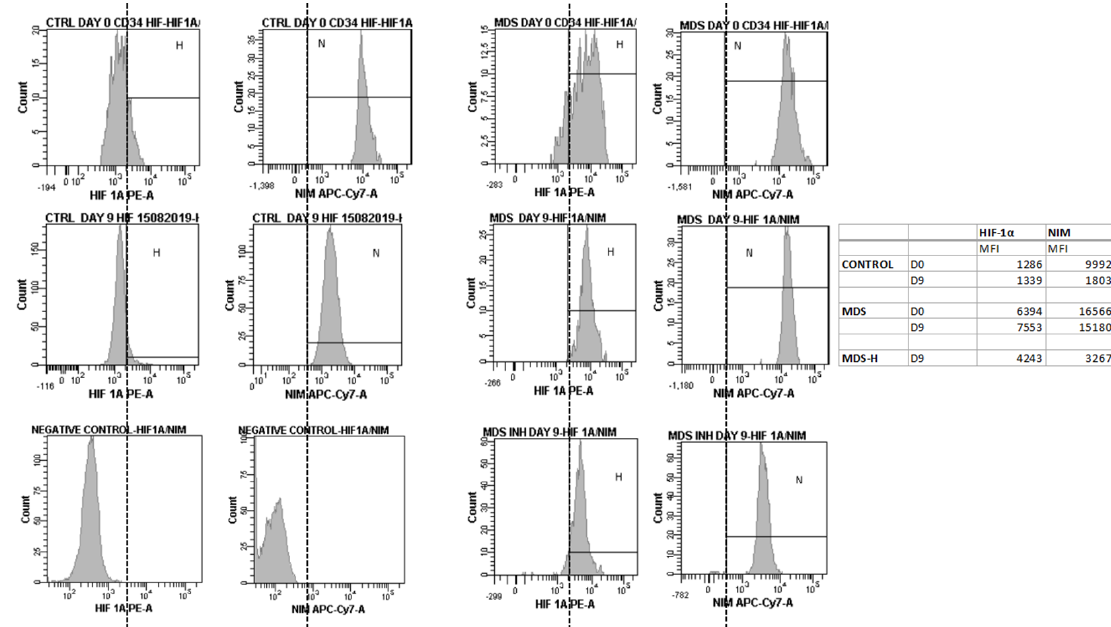
Figure 6. HIF-1 α and NIM median fluorescence intensity (MFI) plots, assessed by flow cytometry, in differentiating control and MDS CD34+ cells cultured in vitro under normoxic conditions. Control cells exhibit low HIF-1 α expression during differentiation, with a rather stable HIF-1 α MFI (d0: 1286, d9: 1339). MDS cells maintain higher levels of HIF-1 α expression during differentiation, even under normoxic conditions, with higher HIF1 α MFI levels compared to controls and a trend of increase in HIF-1 α MFI from d0 to d9 (d0: 6394, d9: 7553). NIM MFI tends to decrease during the normoxic culture of CD34+ control cells (d0: 9992, d9: 1803), while it exhibits higher levels that remain increased during the normoxic culture of MDS cells (d0:16566, d9: 15180). HIF-1 α inhibition in MDS CD34+ cell culture decreases the levels of NIM expression on d9 (NIM MFI 3267 vs. 15180 without inhibition). Due to NIM-IDC autofluorescence, different samples from each culture were used to assess HIF-1 α and NIM-IDC fluorescence each day.